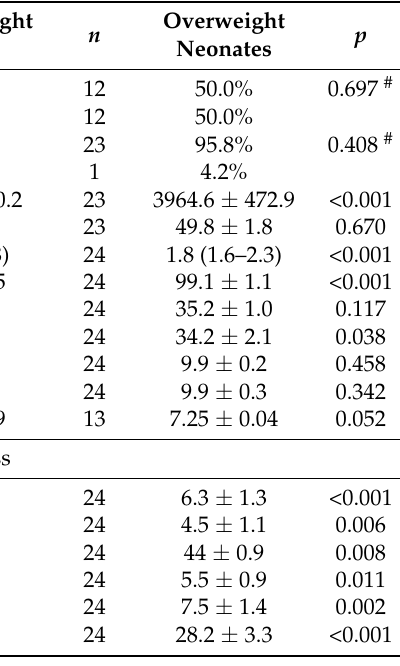
Table 4. Neonatal and laboratory data of two study